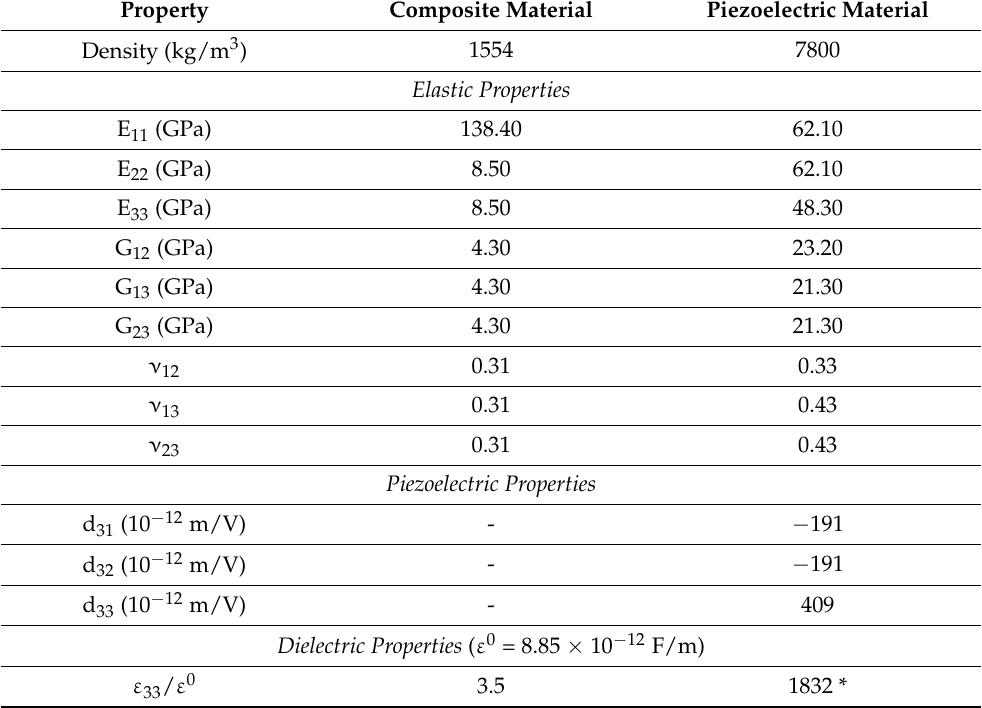
Table 2. Electromechanical properties of materials considered (* under constant